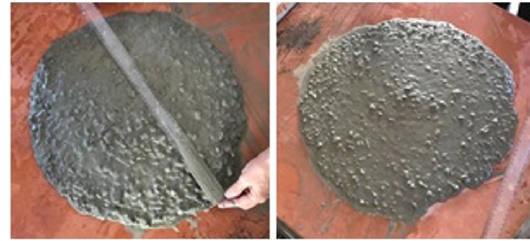
Figure 4. Slump flow measurement (a) HPC (b) SCC.